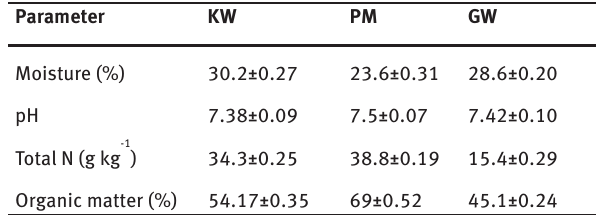
Table 1: Properties of the compost